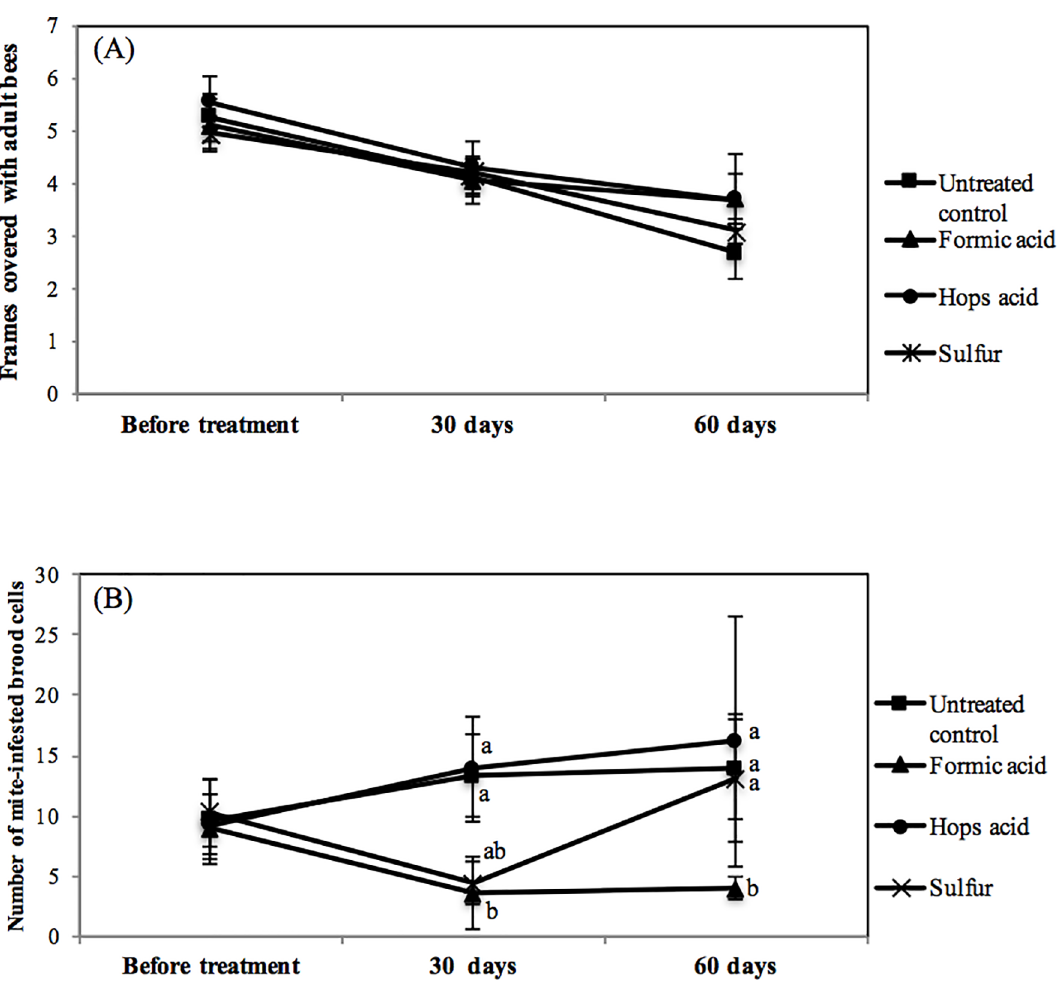
Fig 2. Average (mean ± SEM) number of framescovered in adult bees (A) and number of Tropilaelaps -infested cells observed by uncapping 100 sealed brood cells (B) from honey bee colonies treated with three different mite control products and untreated controls in the dry season. Treatment period was ca. 30–45 days dependent upon control material. Letters indicatesignificantdifferences betweentreatment means (ANOVA, P <